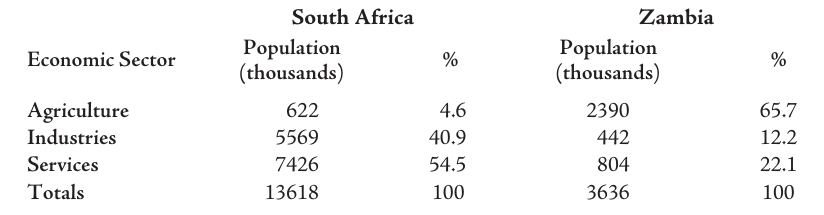
Table 4 – Major Imports According to Product Group, 1995 Table 5 – Distribution of Economically Active Population, 1997